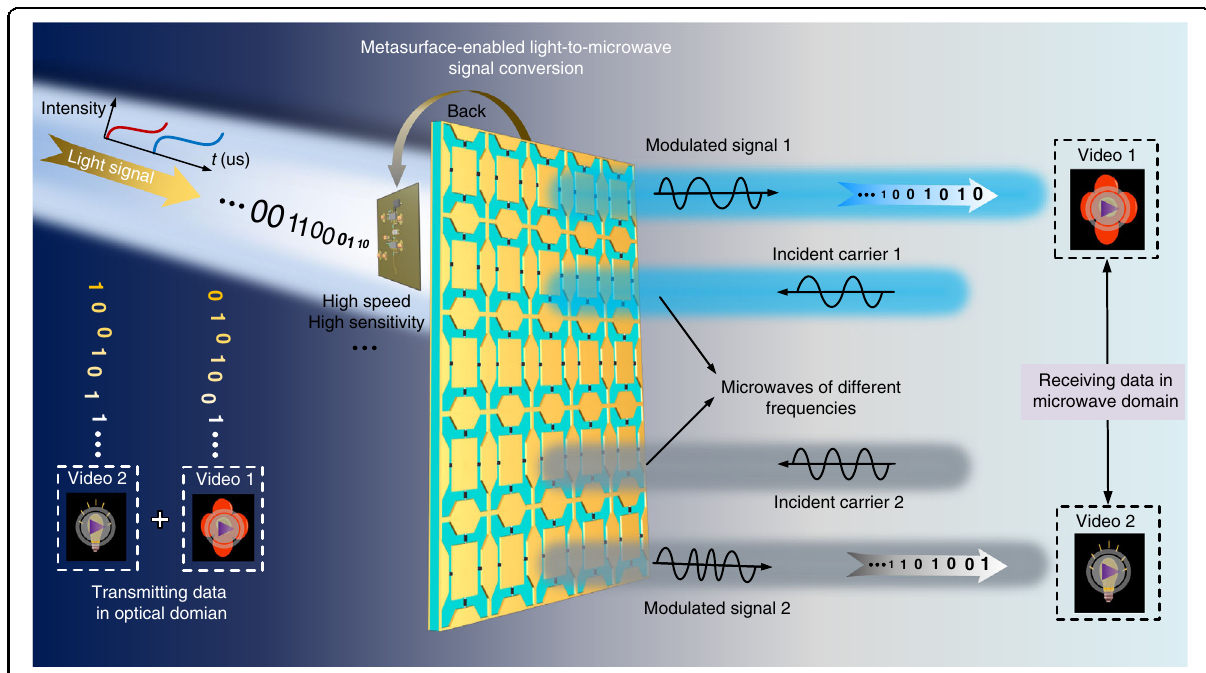
Fig. 1 Schematic of direct light-to-microwave signal conversion using a hybrid time-varying metasurface platform. The metasurface platform is realized by integrating a high-speed and high-sensitivity photoelectric detection circuit into the back of a programmable microwave metasurface, where the re fl ection spectrum of metasurface can be manipulated by the light waveform in real time, thus providing a bridge to link the light signal and microwave signal. By further using the dispersion characteristics of the metasurface, one designed light intensity signal can be directly converted to two different BFSK signals for implementing FDM. Therefore, a light-to-microwave transmitter can be well realized. With this metasurface-enabled transmitter, a dual-channel light-to-microwave wireless link is built up, in which two different videos can be transmitted and received simultaneously and